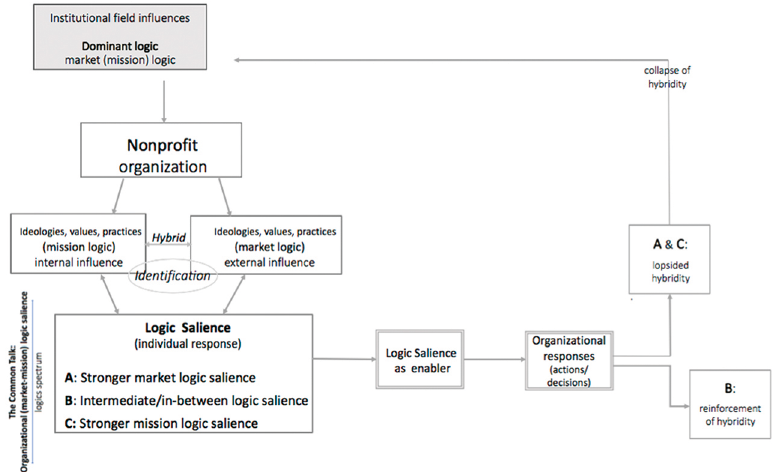
Figure 2: Logic Salience as enabler of